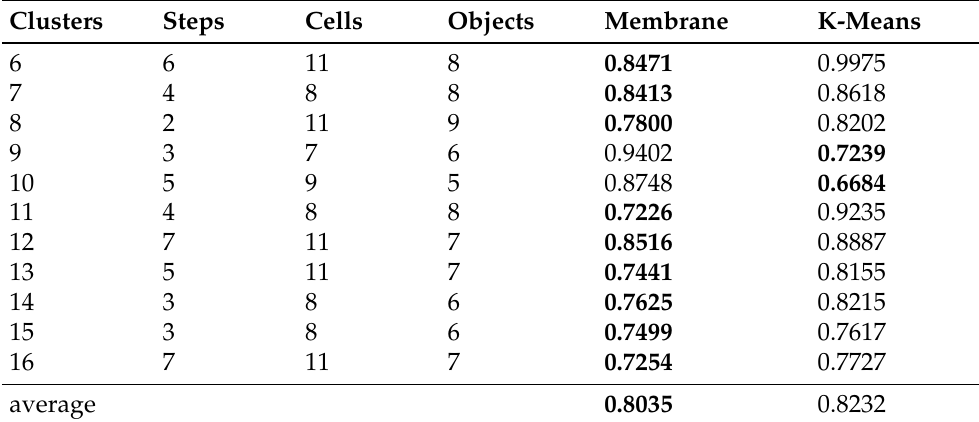
Table 8. Davies–Bouldin scores of the K-Means and the membrane clustering with the different number of clusters and m between 4 and 16 and using different membrane configurations. The Better scores are bold in the